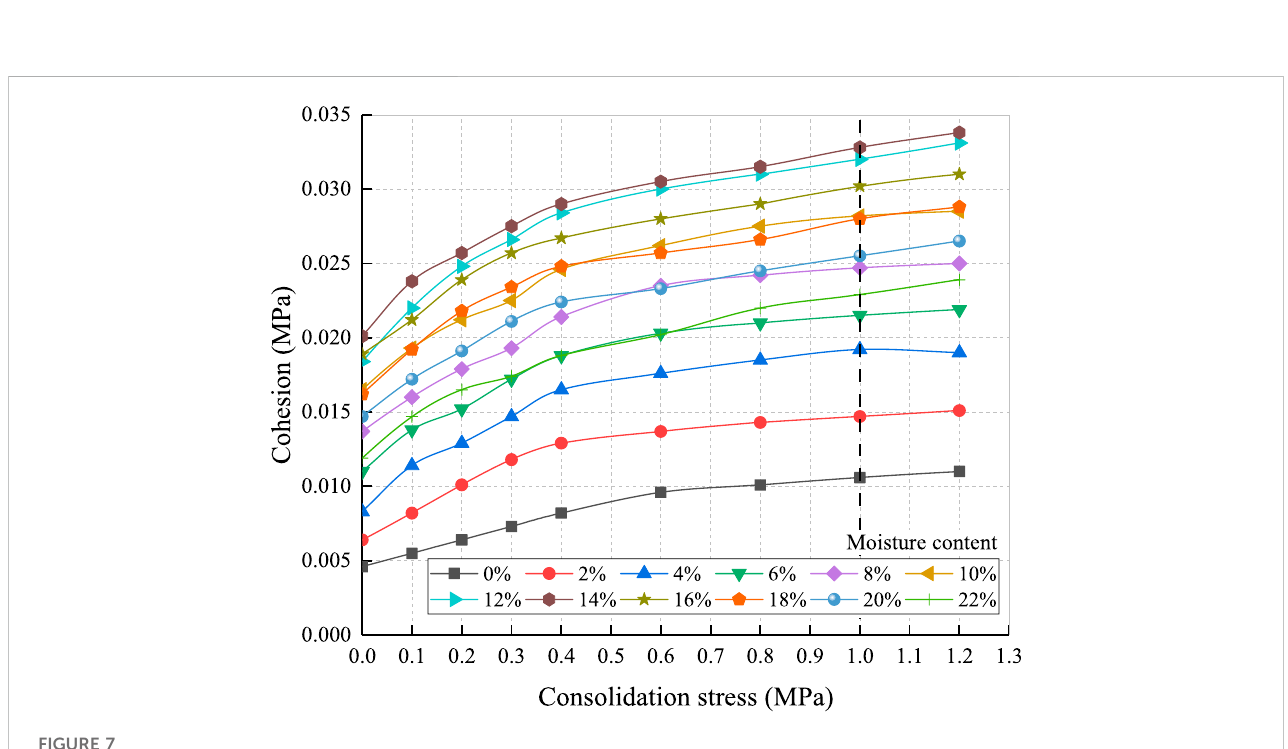
FIGURE 7 Relationship between cohesion and consolidation